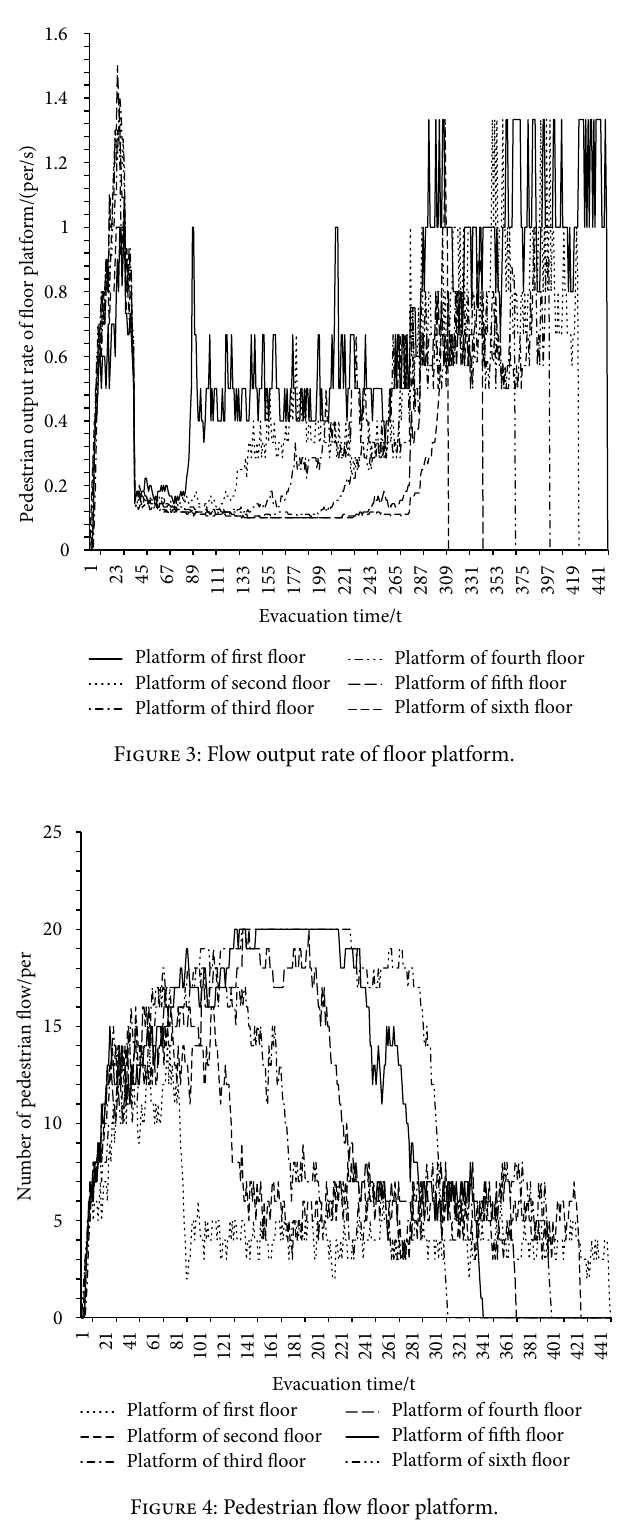
Figure 4: Pedestrian flow floor platform.